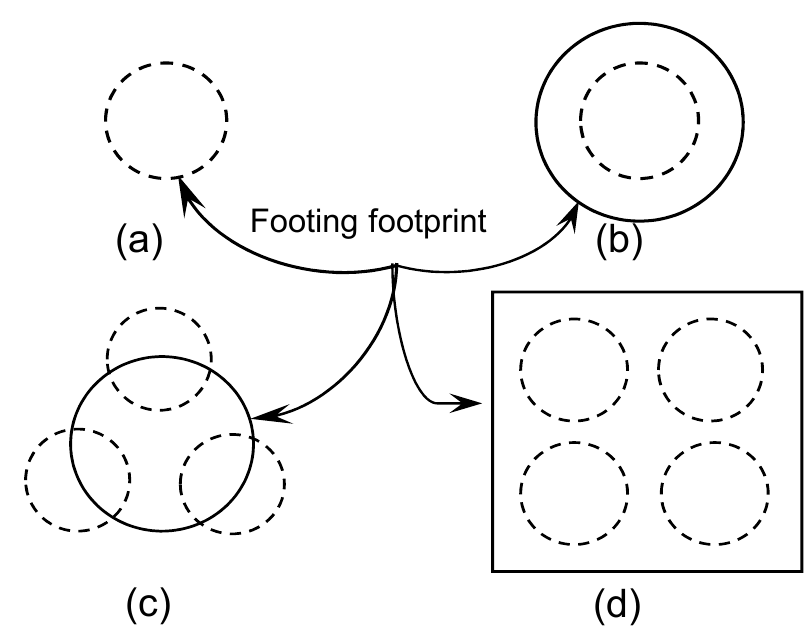
Figure 1. Common aggregate pier configurations for spread footings: ( a ) single isolated pier, ( b ) intermediate single pier, ( c ) intermediate group of piers, and ( d ) group of piers (Stuedlein and Holtz [18]).